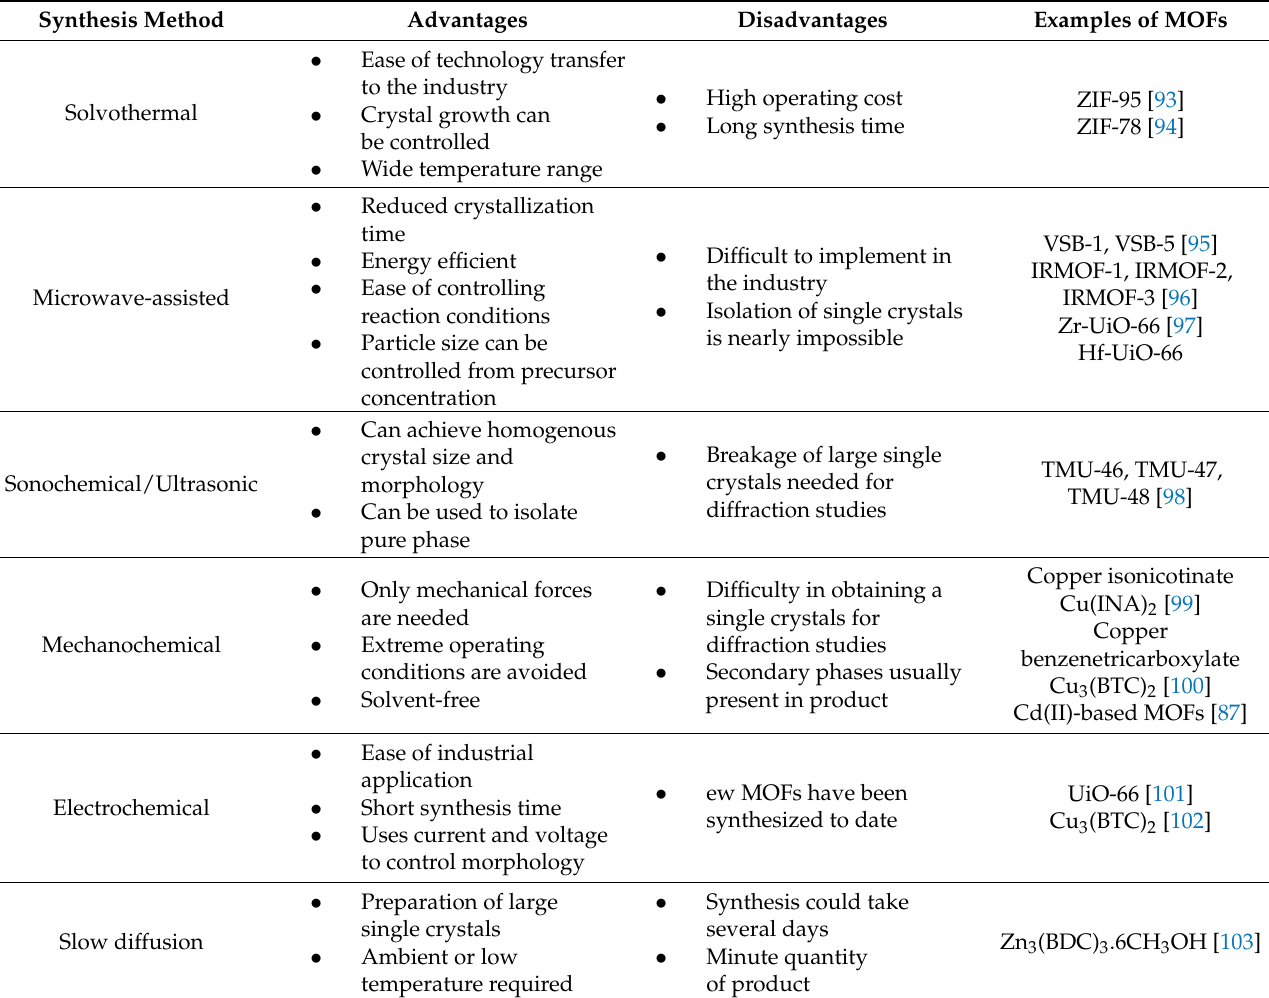
Table 4. Summary of MOF synthesis